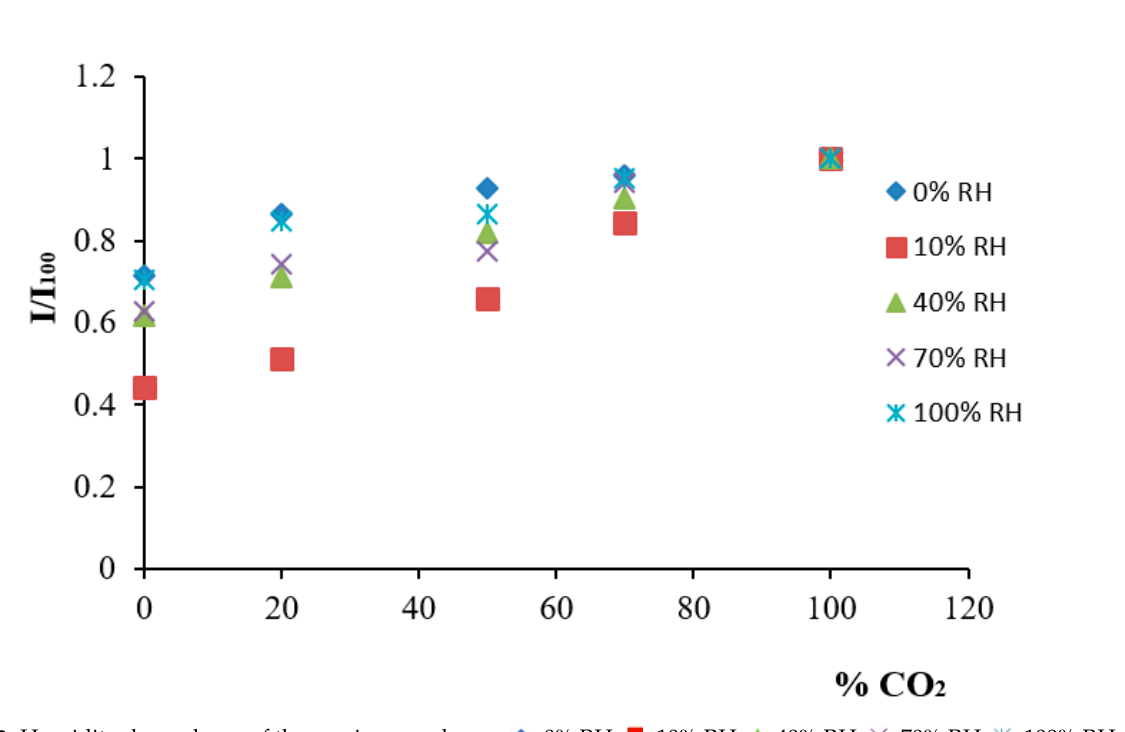
Figure 2. Humidity dependence of the sensing membrane: : 0%RH; : 10% RH; :40% RH; :70%RH; : 100%RH.